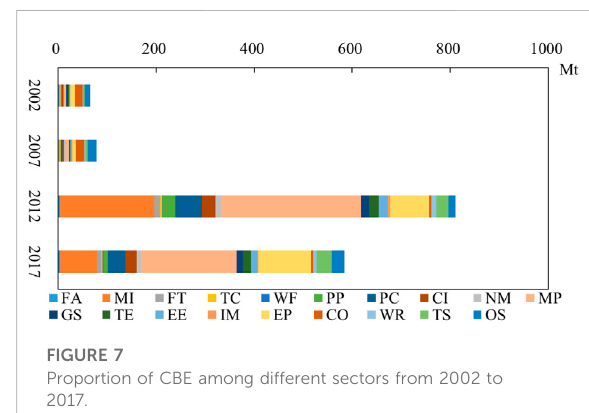
FIGURE 7 Proportion of CBE among different sectors from 2002 to